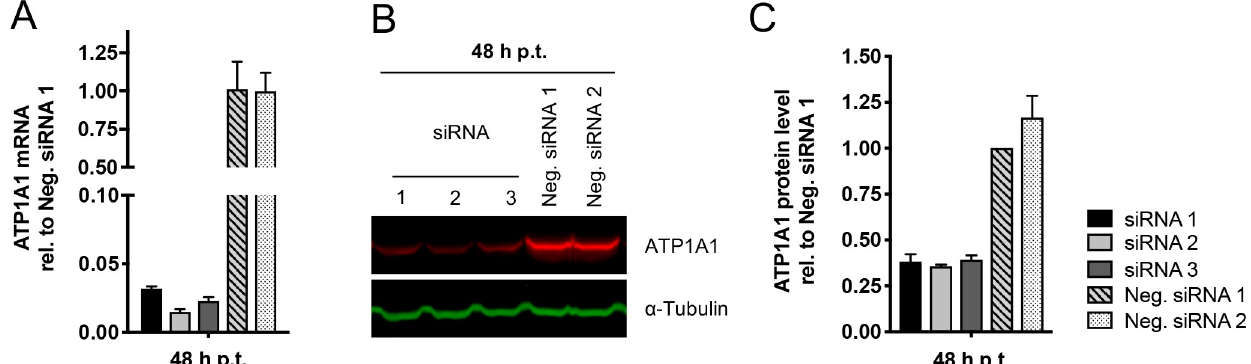
Fig 1. ATP1A1 knock down by siRNA transfection. A549 cells were transfected individually with siRNAs 1, 2, and 3 targeting the ATP1A1 mRNA, as well as with scrambled negative controls Neg. siRNA 1 and 2 that have no known target in human cells. Cells were harvested 24, 48 and 72 h post transfection (p. t.) and the ATP1A1 mRNA and protein levels were quantified. (A) Relative quantification of ATP1A1 mRNA. Total RNA was isolated, reverse transcribed, and quantified by an ATP1A1-specific TaqMan Assay. Values were normalized to 18S rRNA and expressed as mean values relative to Neg. siRNA 1 assigned the value of 1.0, with error bars indicating the standard deviation of three independent experiments with three replicate reactions each. (B) Western blot analysis of ATP1A1 expression. Cells were lysed at 48 h p.t. and subjected to Western blotting with an anti-ATP1A1 rabbit monoclonal antibody (MAb) (ab76020) and a corresponding infrared dye 680RD-conjugated goat anti-rabbit secondary antibody. Alpha-tubulin was used as a loading control and was detected by an anti-alpha-tubulin mouse MAb and an infrared dye 800CW-conjugated goat anti-mouse secondary antibody. A representative blot is shown. (C) Quantification of ATP1A1 Western blots . Western blot analyses of three independent experiments, as described in Part B, were quantified, normalized to alpha-tubulin, and reported relative to Neg. siRNA 1 assigned the value of 1.0, with error bars indicating the standard